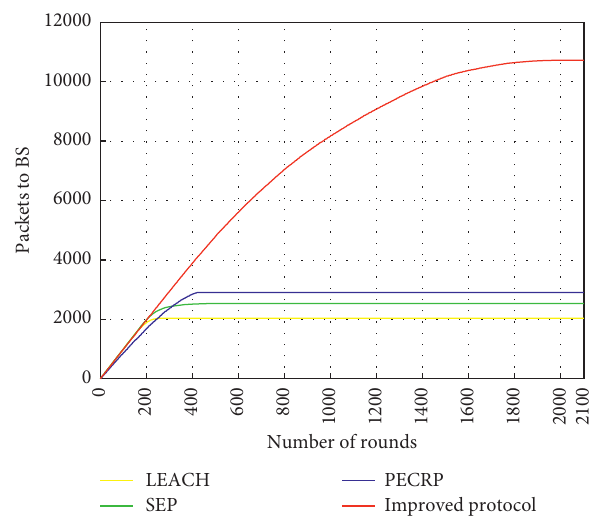
Figure 12: Comparison of packets sent to BS from CHs without power supply.